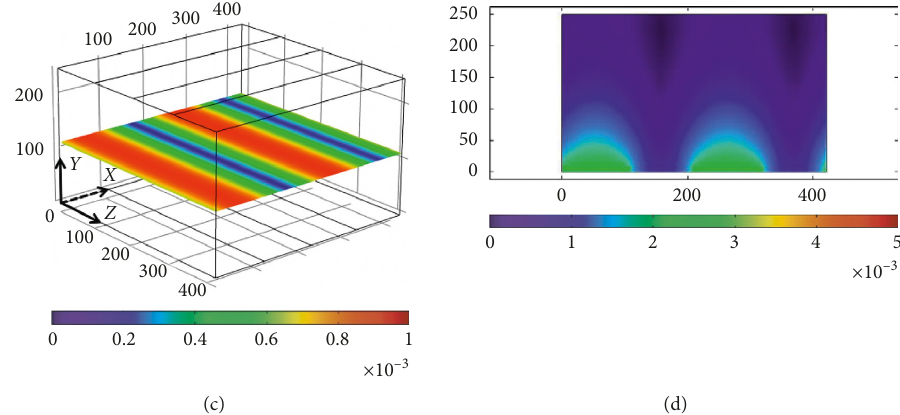
Figure 4: Static displacement distribution at a crystal thickness of 250 μ m measured in μ m. The d displacements measured (a) at the middle of the crystal along X -axis direction and (b) along thickness. Total static displacement measured (c) in the middle of the crystal and (d) along the thickness.